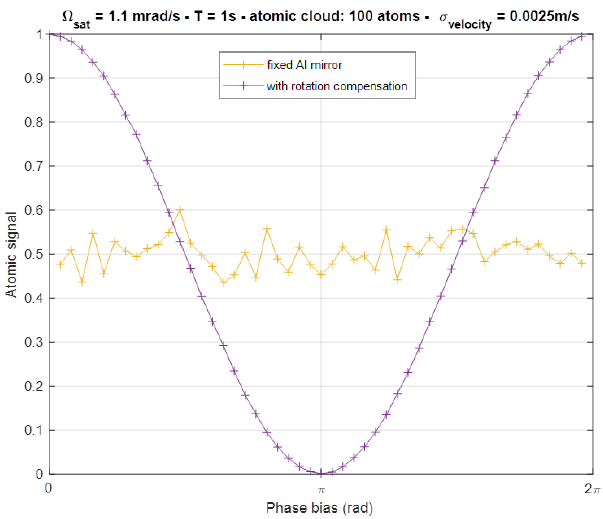
Figure 23. Interferometric signal when using a fixed CAI reference mirror (yellow) and when using the electrostatic proof-mass, acting as the reference mirror, to compensate for the satellite rotation (purple). The simulation is performed with a simulated atomic cloud of 100 atoms, a standard deviation of the atomic velocities of 2.5 mm/s, of the initial atomic positions of 2 mm, and an interrogation time of T = 1 s.